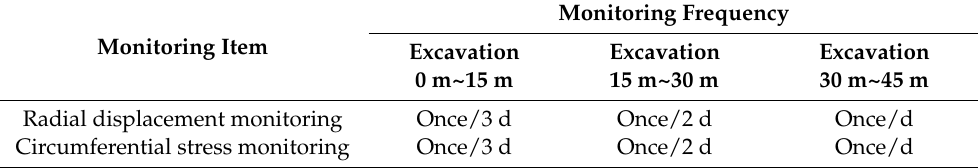
Table 3. Monitoring